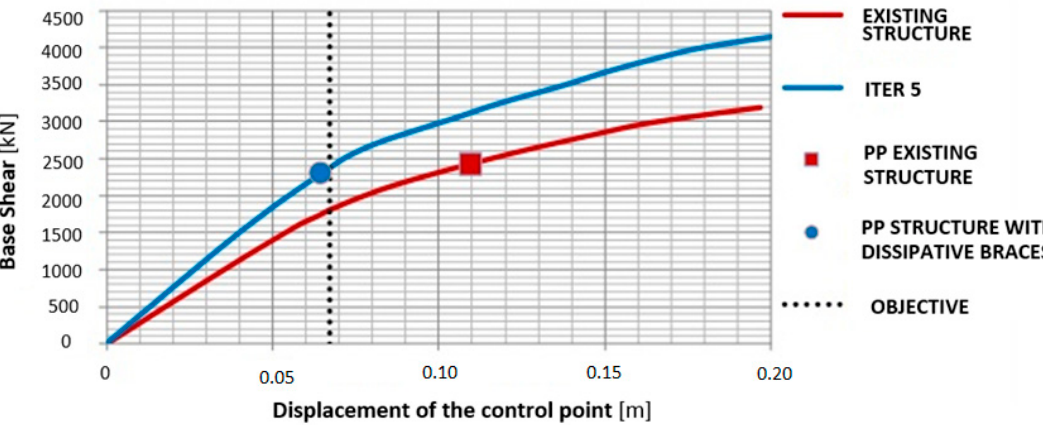
Figure 13. Capacity curves in Y direction after retrofitting, with the relative performance points (PP) and objective displacement.